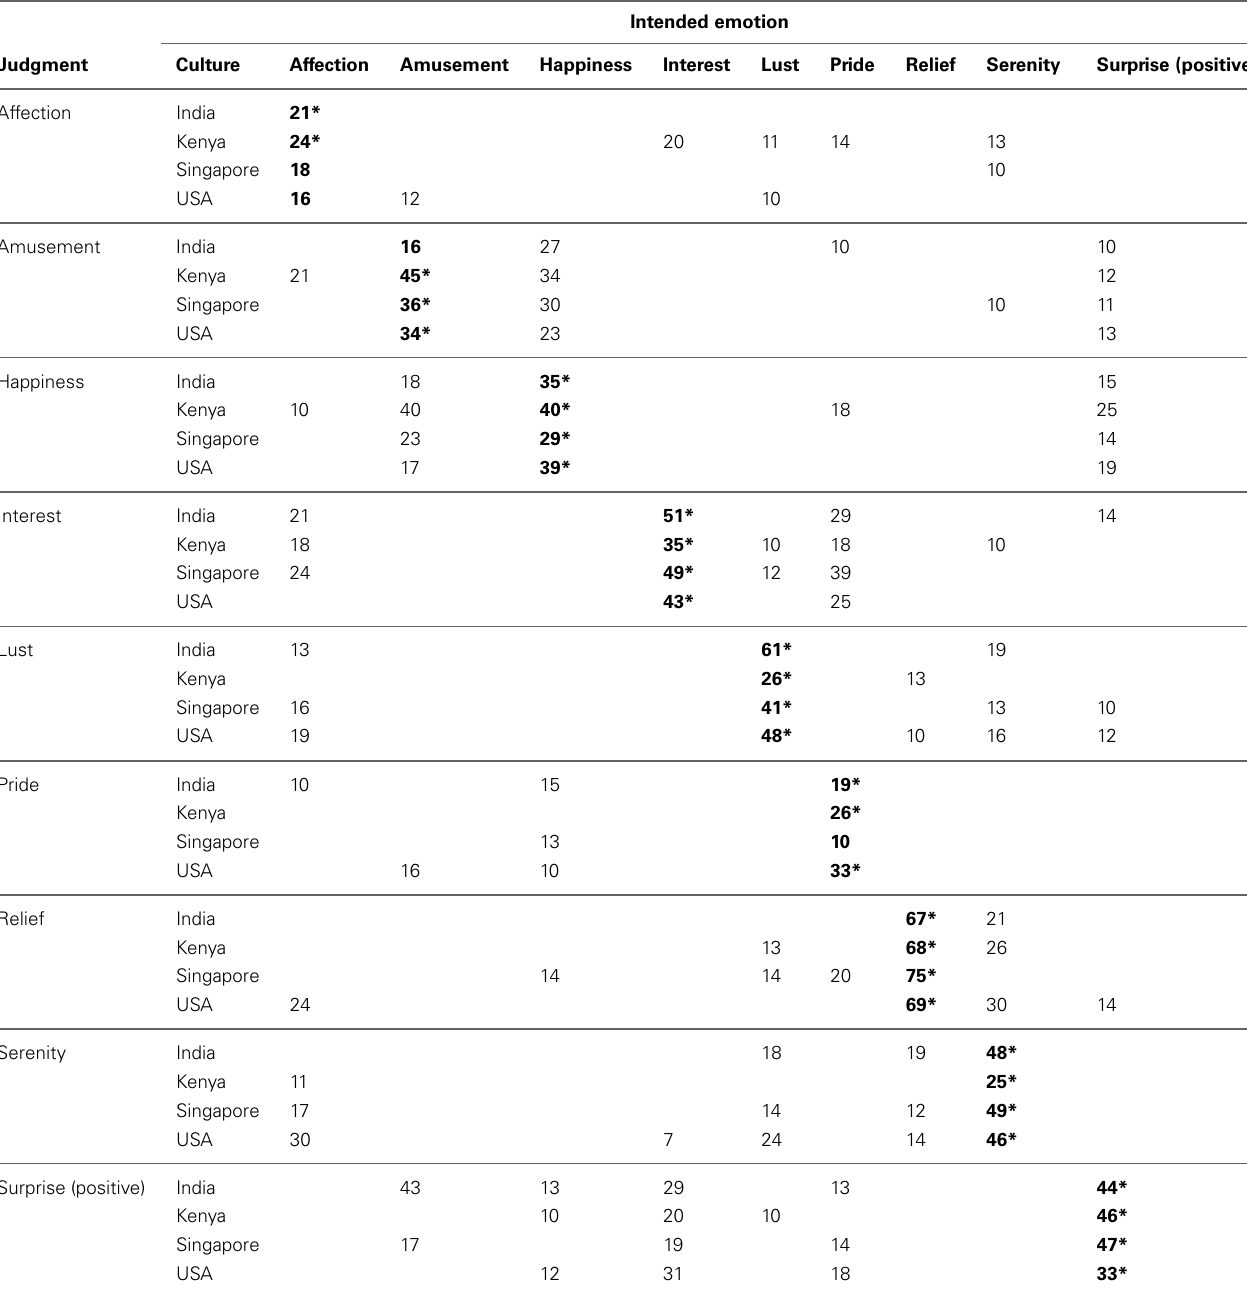
Table 2 | Recognition rates and confusion patterns for non-linguistic vocalizations of nine positive emotions from four cultures. Intended